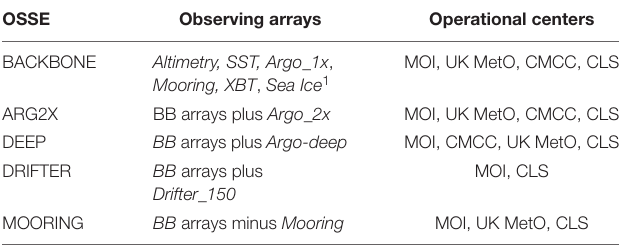
TABLE 2 | List of OSSEs performed by each group. OSSE Observing arrays Operational